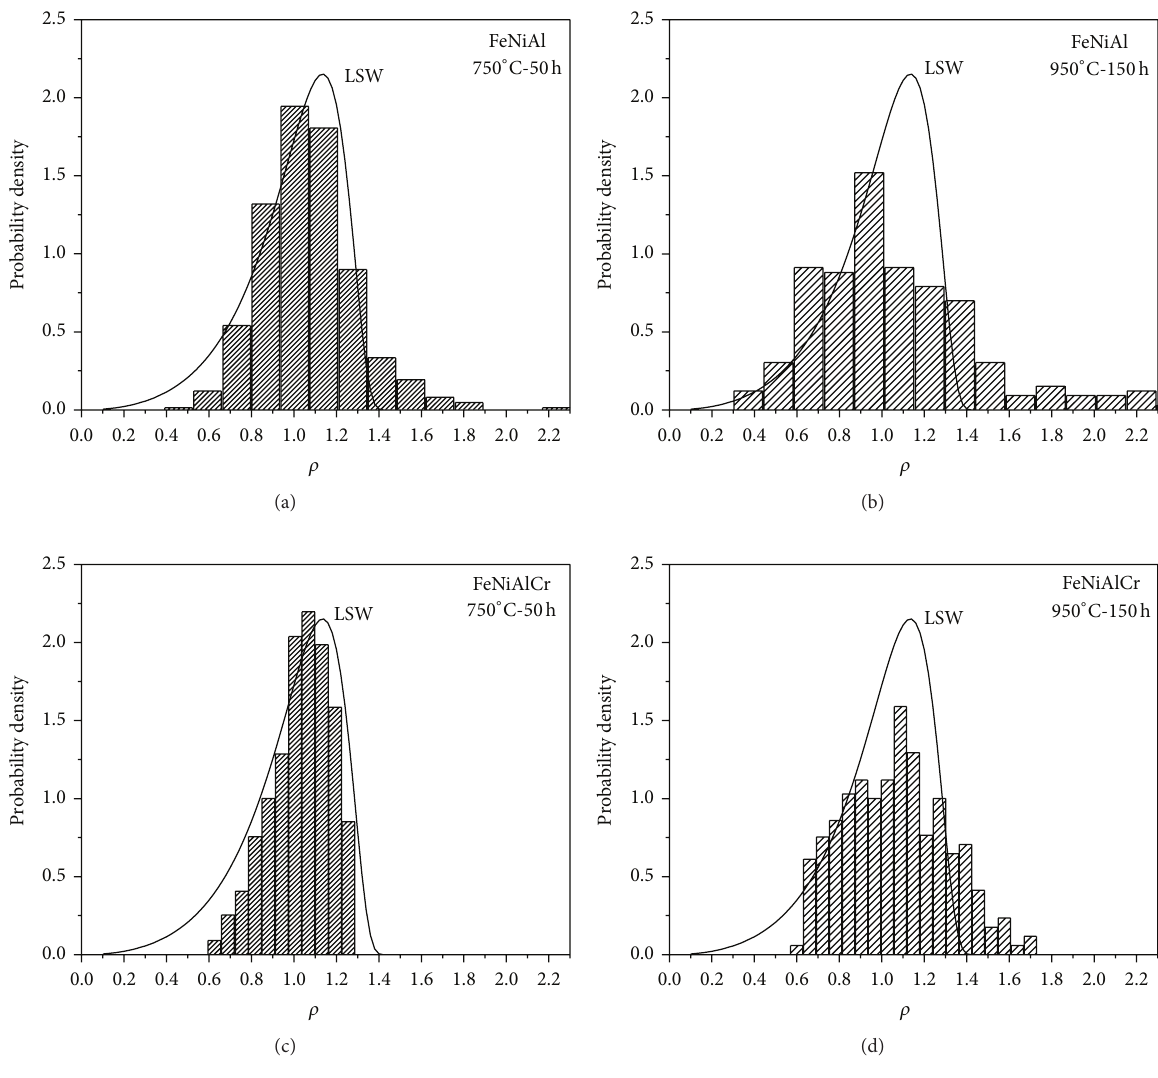
Figure 7: Distribution of precipitate size for the (a-b) Fe 0.75 Ni 0.10 Al 0.15 and (c-d) Fe 0.74 Ni 0.10 Al 0.15 Cr 0.01 alloys aged at 750 ∘ C for 50 h and 950 ∘ C for 150h,